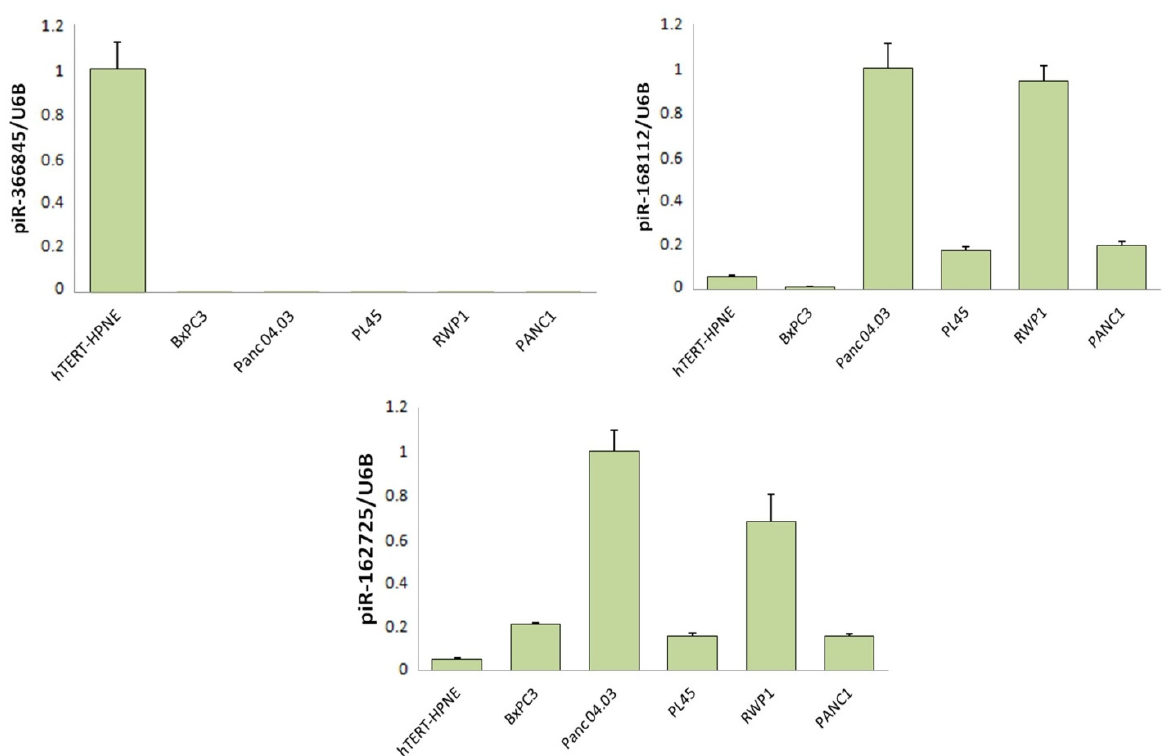
Figure 2. Validation of the three piRNAs obtained from the NGS of small RNA in untransformed and pancreatic-cancer-derived cell lines. Statistically significant piRNAs obtained from data integration and analyses from the NGS of small RNA ( pir-366845 , piR-168112 , and piR-162725 ) were evaluated in one untransformed human pancreatic cell line (hTERT-HPNE) and in five human pancreatic-cancer-derived cell lines. Graphs show piRNA fold-change expression normalised to U6B small nuclear RNA gene (RNU6B) expression. NGS: Next Generation Sequencing.